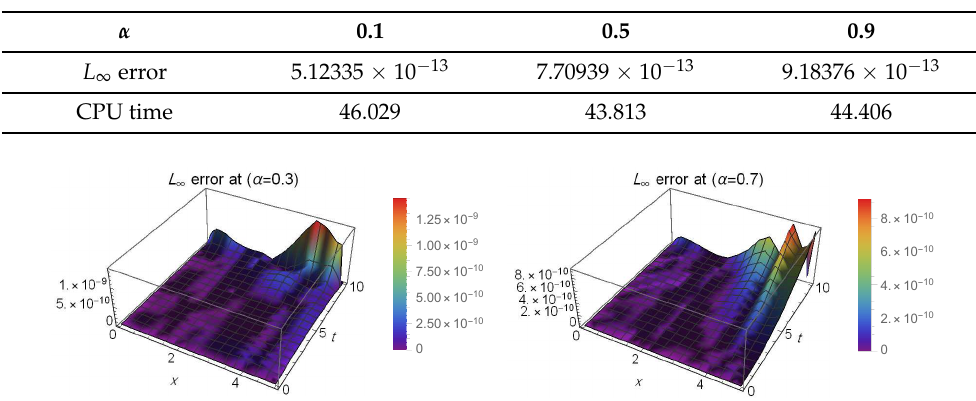
Table 2. The L ∞ errors for Example 1.